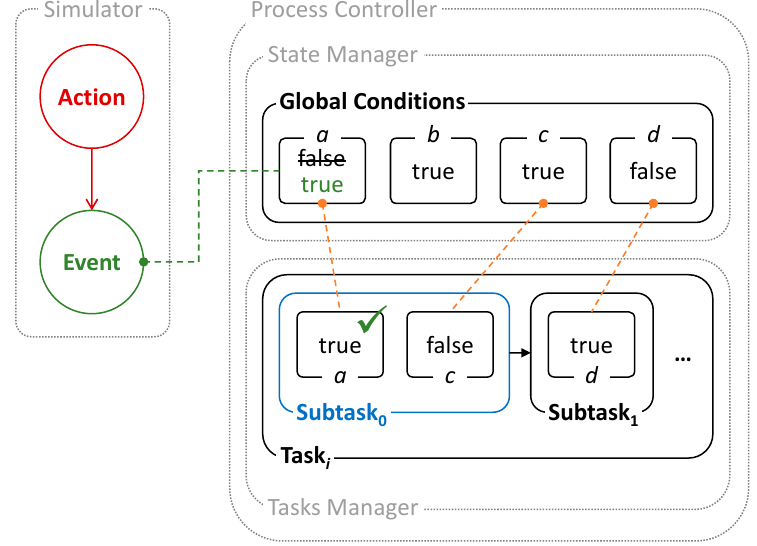
Figure 3. State manager operation.